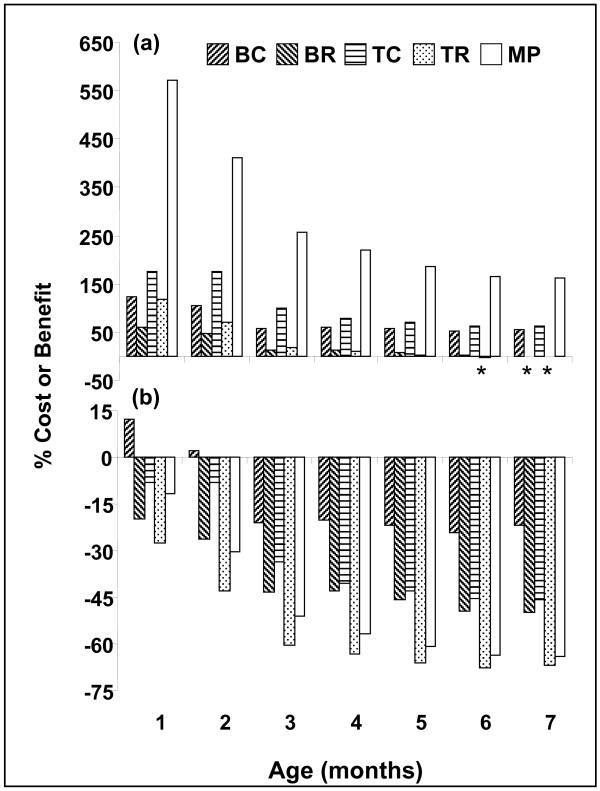
Costs and benefits in terms of calculated areal size (in mm2). (a) per entity and (b) per genotype for BC, BR, TC, TR and MP entities, as compared to SG. Negative values refer to cost, positive values refer to benefit. Asterisks indicate small negative values. See Fig. 2 and text for explanation of abbreviations and sample sizes.